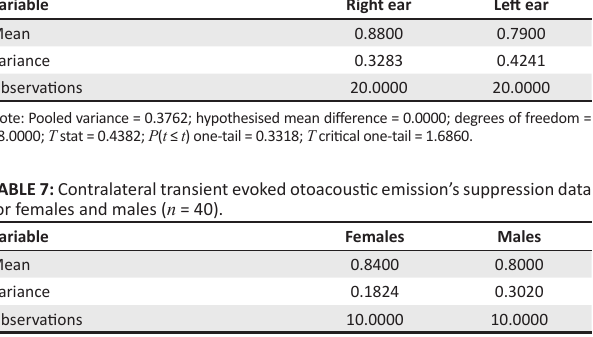
TABLE 6: Contralateral acoustic stimulation suppression for right and left ears ( n = 40). Variable